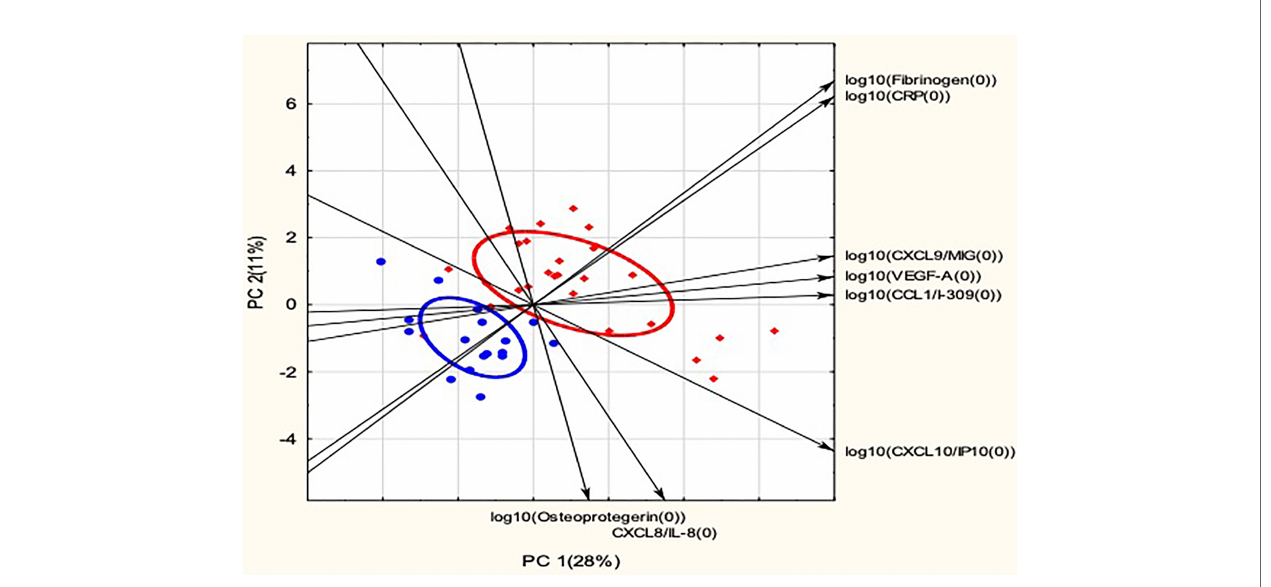
FIGURE 3 | Principal Component Analysis of biomarker distributions in spinal TB and mechanical back pain. Red diamonds indicate scores for spinal TB and blue dots indicate scores for mechanical back pain. Ellipses indicate 50% con fi dence ellipses for spinal TB and mechanical back pain, respectively. Arrows indicate the direction of increasing biomarker levels. Only biomarkers with R 2 > 0.40 for principal components 1 and 2 are shown. PC, Principal Component with the percentage of variation explained by the principal component shown in